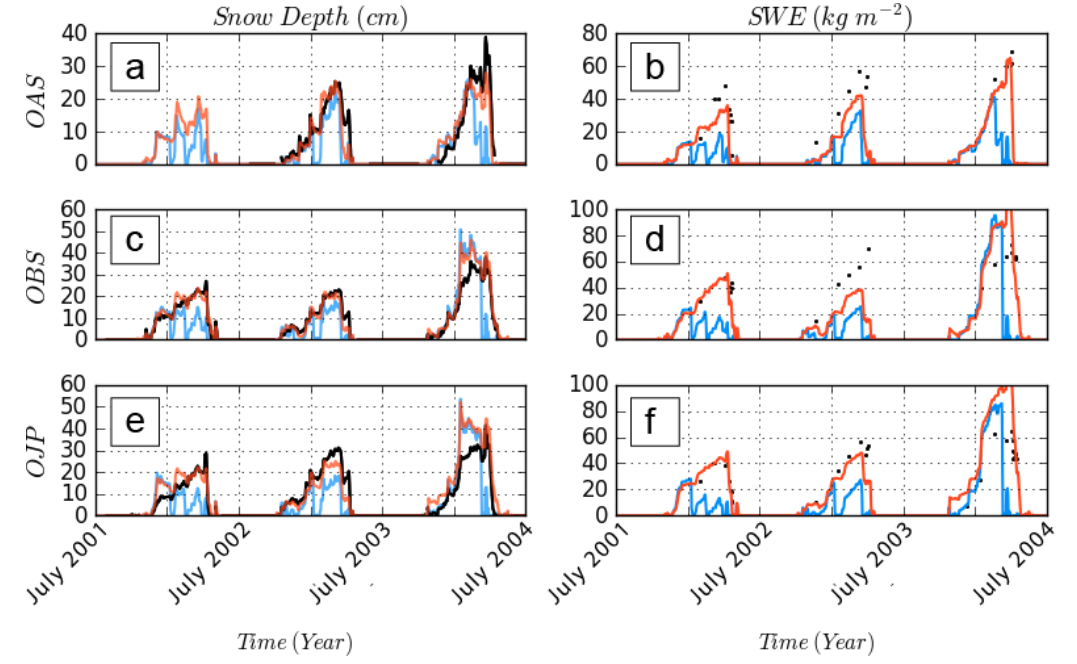
Figure 6. Snow depth (a, c, e) and snow water equivalent (b, d, f) for the three sites from 1 July 2001 to 1 July 2004. MEB is in red, ISBA is in blue, and observations are in black.